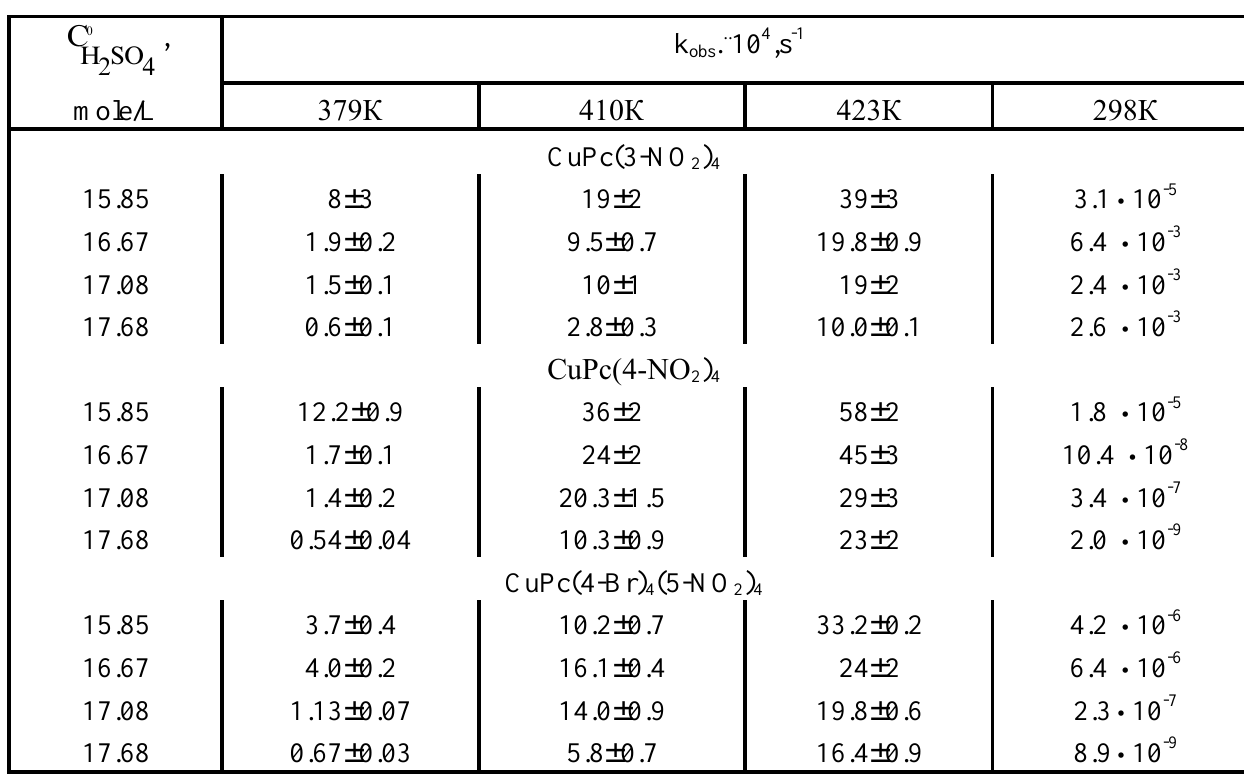
Table 2. Kinetic parameters of dissociation reactions of nitro derivatives of copper(II)phthalocyanine in sulphuric